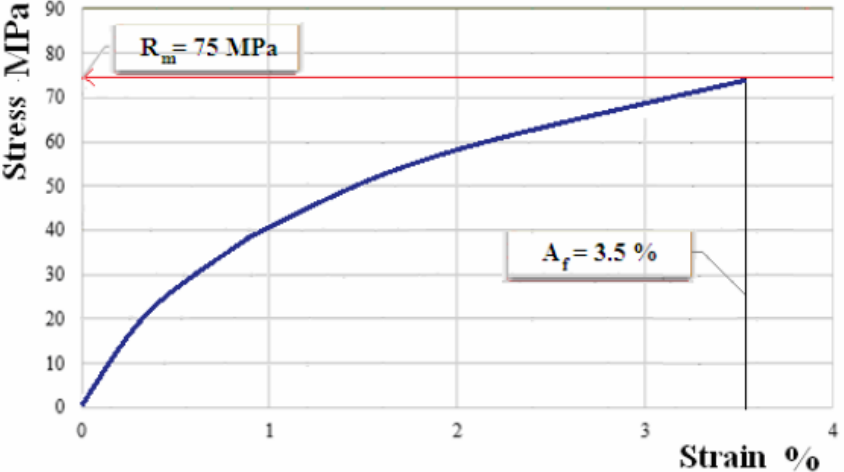
Figure 7. Characteristic curve for sample of composite material with matrix of hybrid resin of type 1, reinforced with fabric of first type.